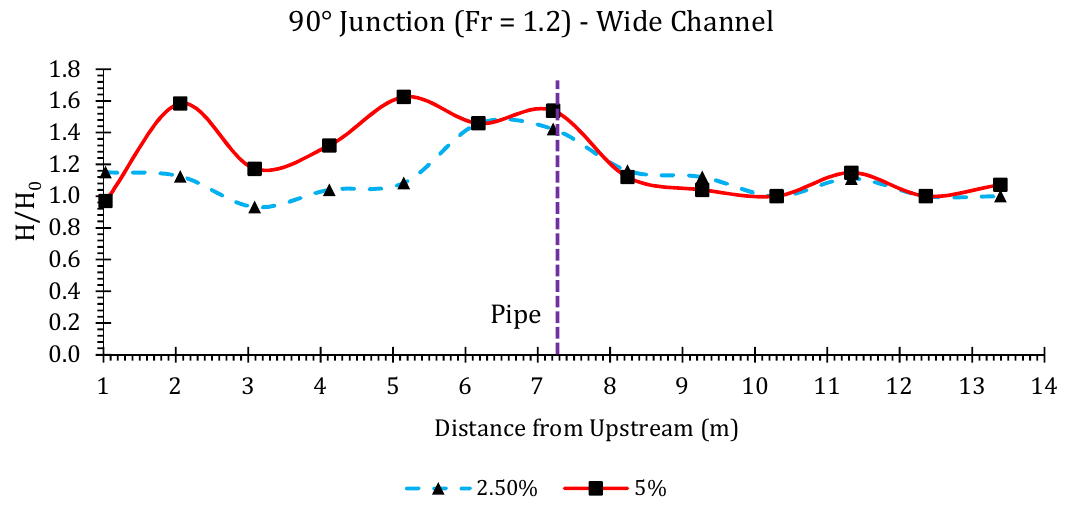
Figure A9. Water height ratios in a 90° junction for Fr = 1.2 in the wide channel.